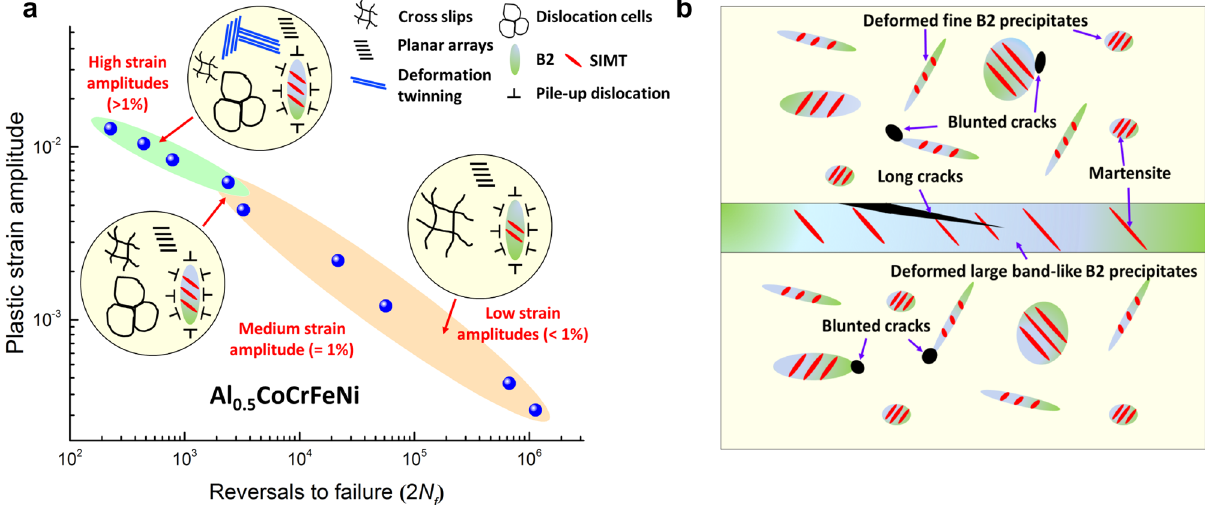
Fig. 6 Schematics of the cyclic-deformation mechanisms and the microcrack-initiation behavior in the studied HEA. a Summary of dominated cyclic- deformation mechanisms of Al 0.5 CoCrFeNi at different strain amplitudes. b Schematic of the microcrack-formation mechanism during cyclic